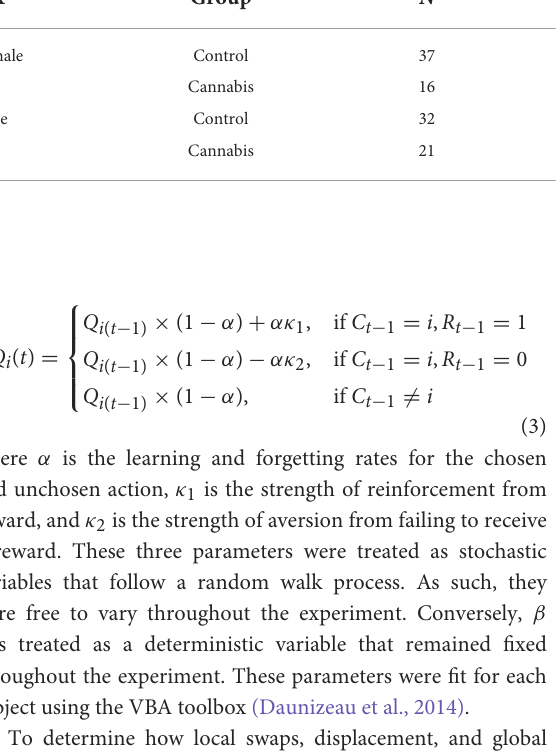
TABLE 1 Demographic data and ASSIST questionnaire scores ( ± SEM) for the studied groups. Sex Group